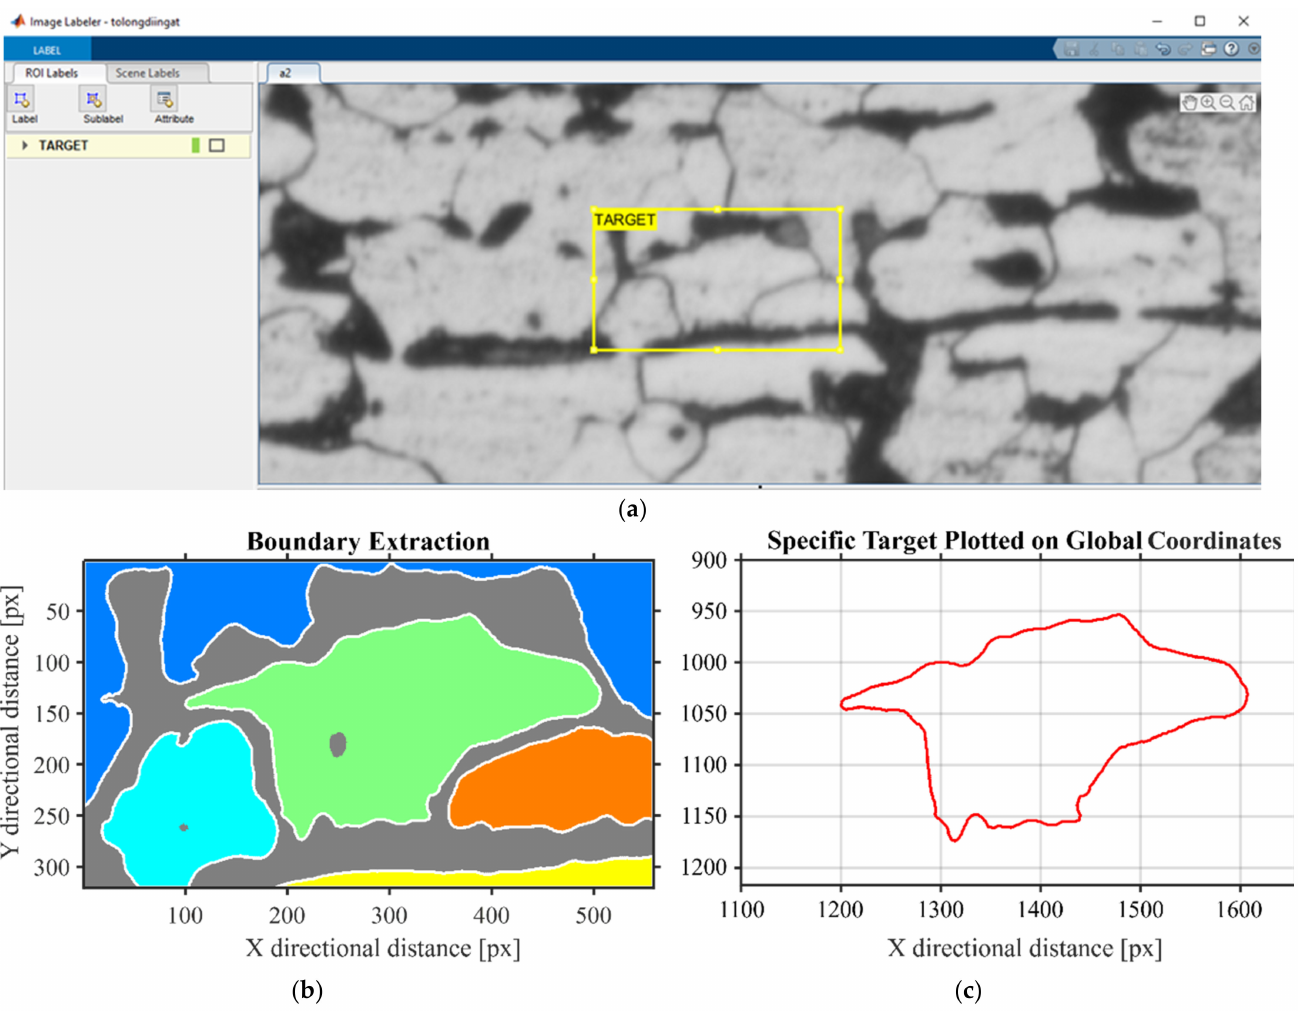
Figure 13. Grain boundary extraction processes: ( a ) target grain labelling using built-it MATLAB apps “Image Labeler”, ( b ) extraction results using Moore–Neighbor tracing algorithm with updated Jacob’s stopping criteria, ( c ) plot of specific grain on global location coordinate by integrating the stitched image, matching, and boundary